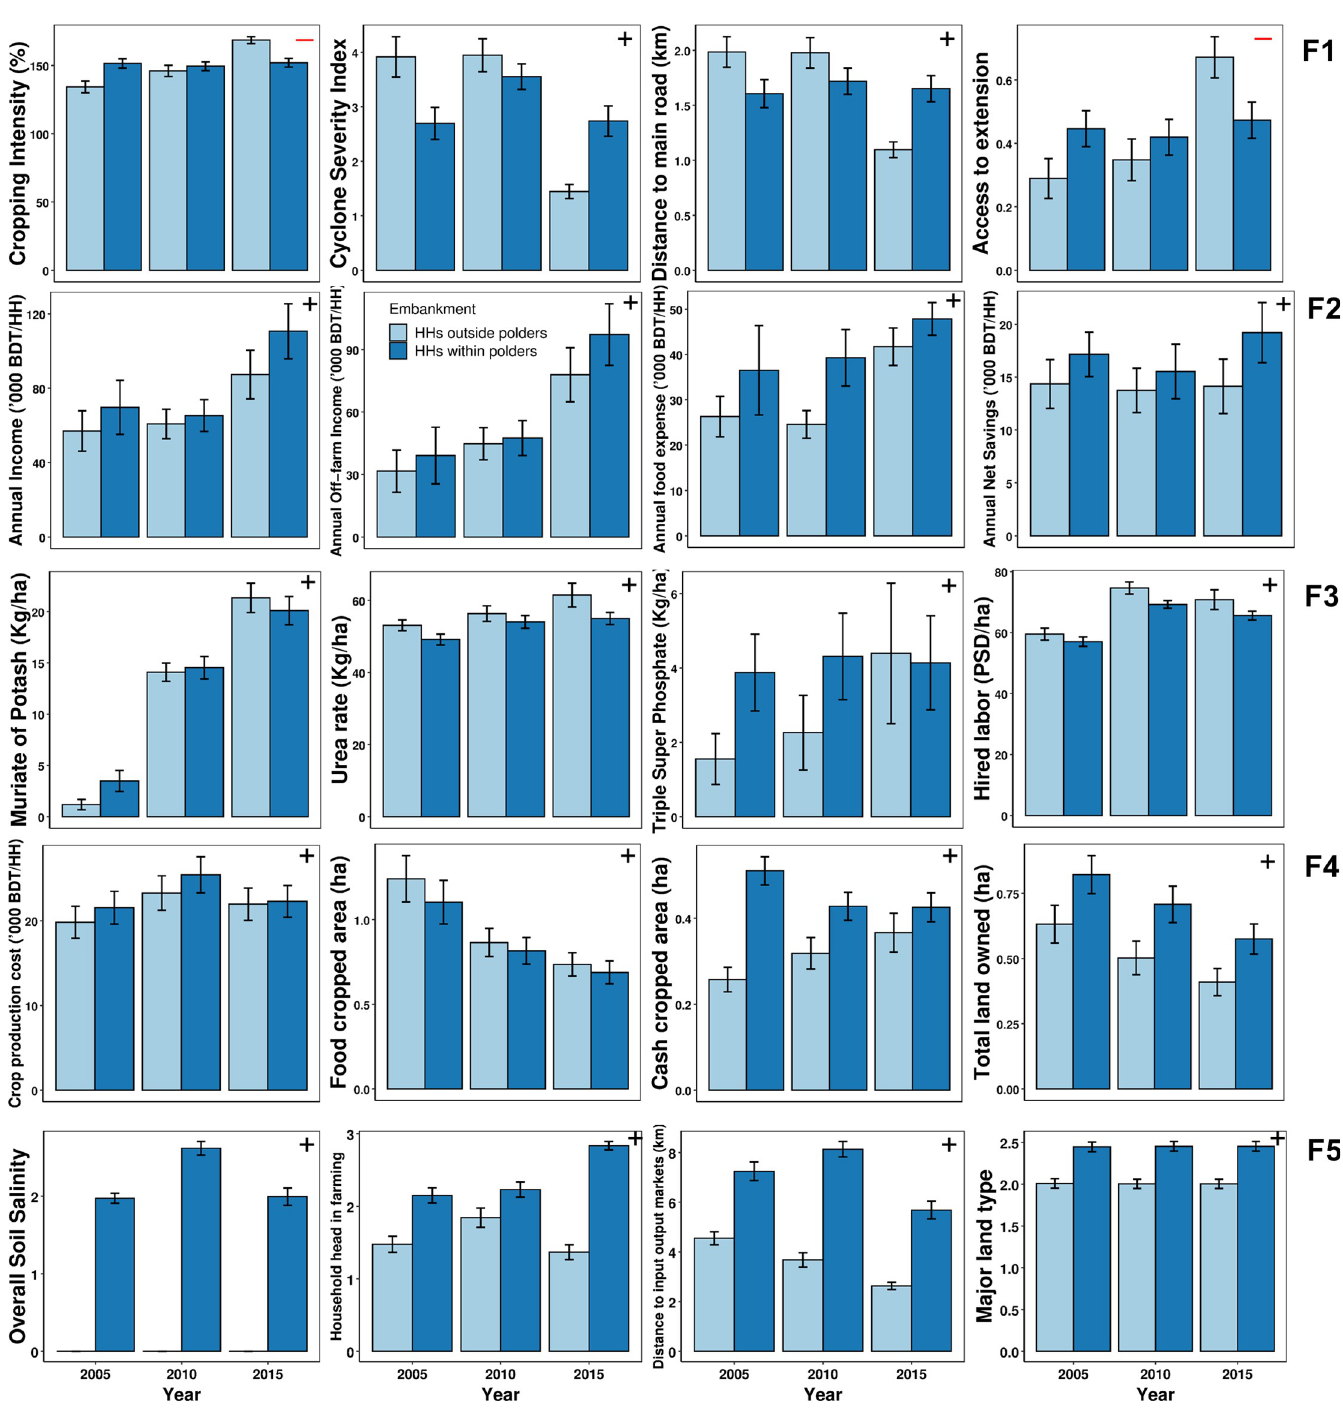
Fig 4. Changes over time in most influential variables contributing to each latent factor during the study period (2005–2015) (error bars indicate 95% confidence intervals). The associated factor from Fig 3 is displayed in each panel. (F1 = Farming challenges, F2 = Economic status, F3 = Crop Management practices, F4 = Asset endowment, F5 = Farm characteristics, and ‘+’ = Positive loading, ‘-’ = Negative loading, HH = Household).